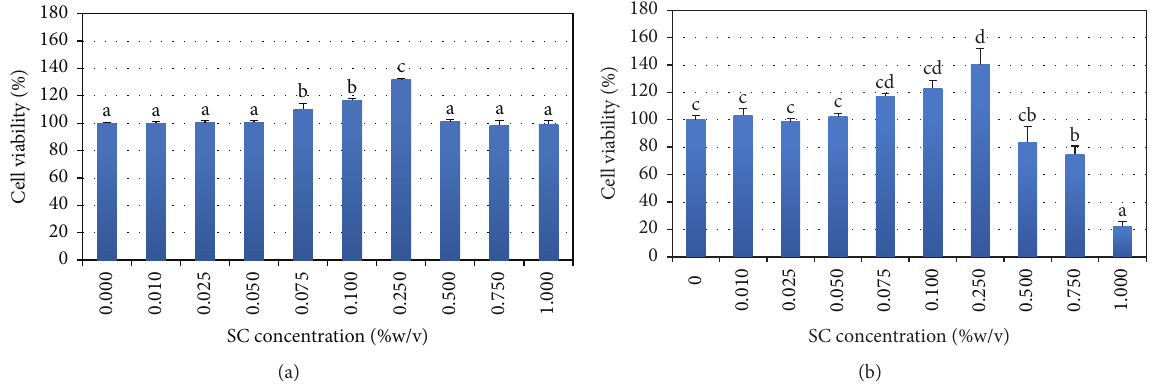
Figure 8: Percentages of cell viability at (a) 24 and (b) 120 hours. Statistical difference is indicated by the lowercase letters (a, b, c, and d) ( 𝑝 ≤ 0.05 ).